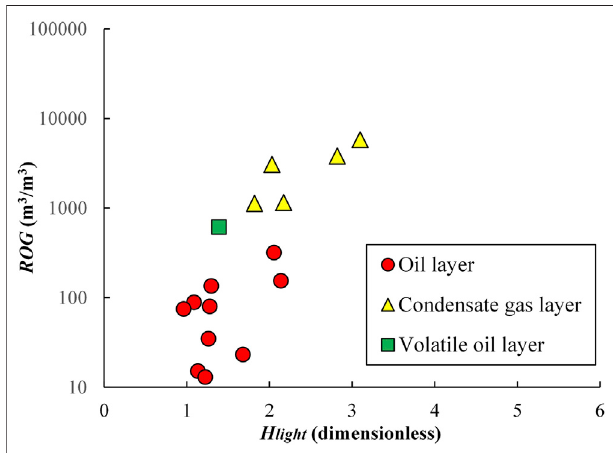
FIGURE 5 | The cross-plot between production gas-oil ratio with H light .